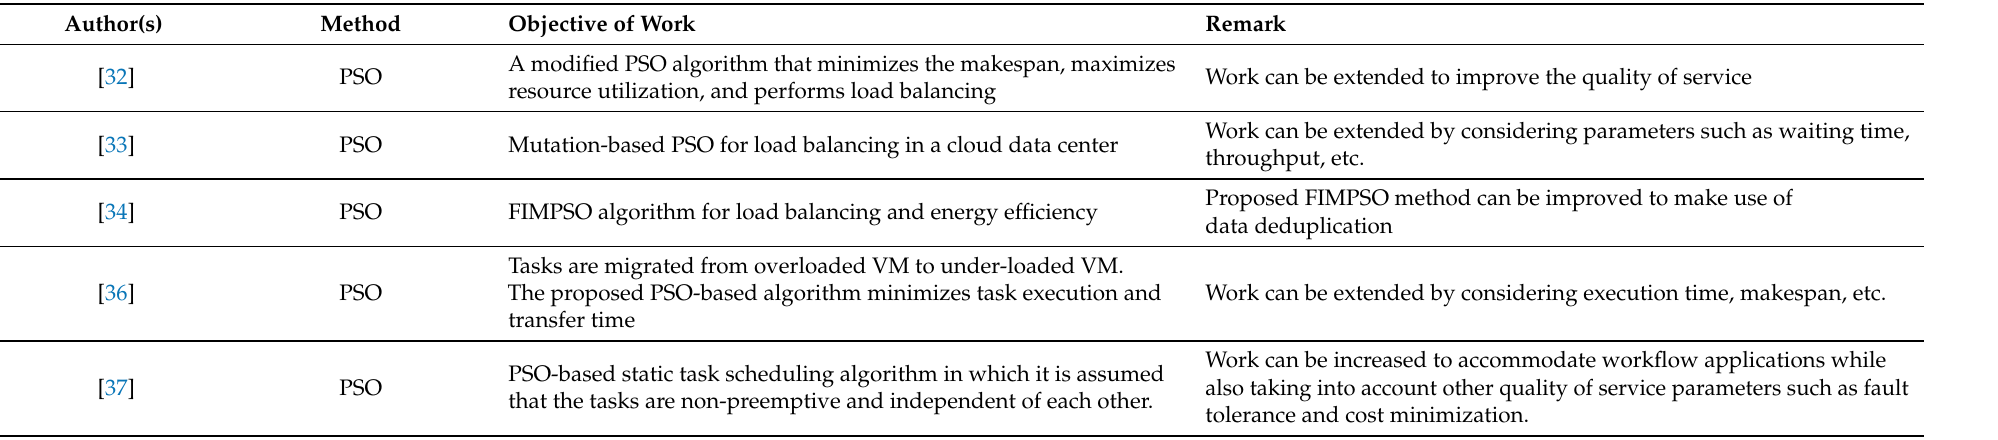
Table 2. Review of different Meta-heuristic Load Balancing Approaches Using PSO.